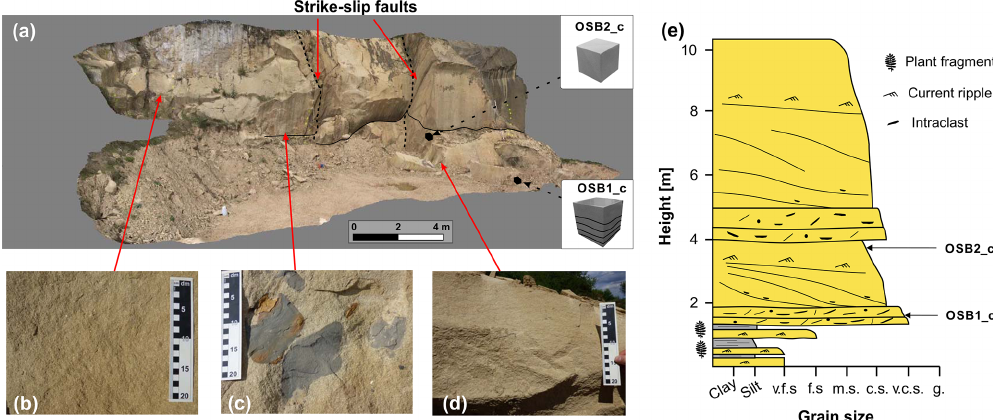
Figure 1. (a) The investigated sandstone quarry in Obersulzbach, Germany. The outcrop is compartmentalized in the central part by two strike-slip faults which belong to the Lauter fault zone (Stollhofen, 1998). The strike-slip faults provide offsets of a few meters. (b) Massive sandstone. (c) Pelitic rip-up clasts embedded in a massive rock matrix. (d) Ripple-cross bedded sandstone. (e) Cumulative sedimentary log of the outcrop architecture. The sampling positions of OSB1_c and OSB2_c are marked in the sedimentary log (v.f.s. – very fine sand; f.s. –